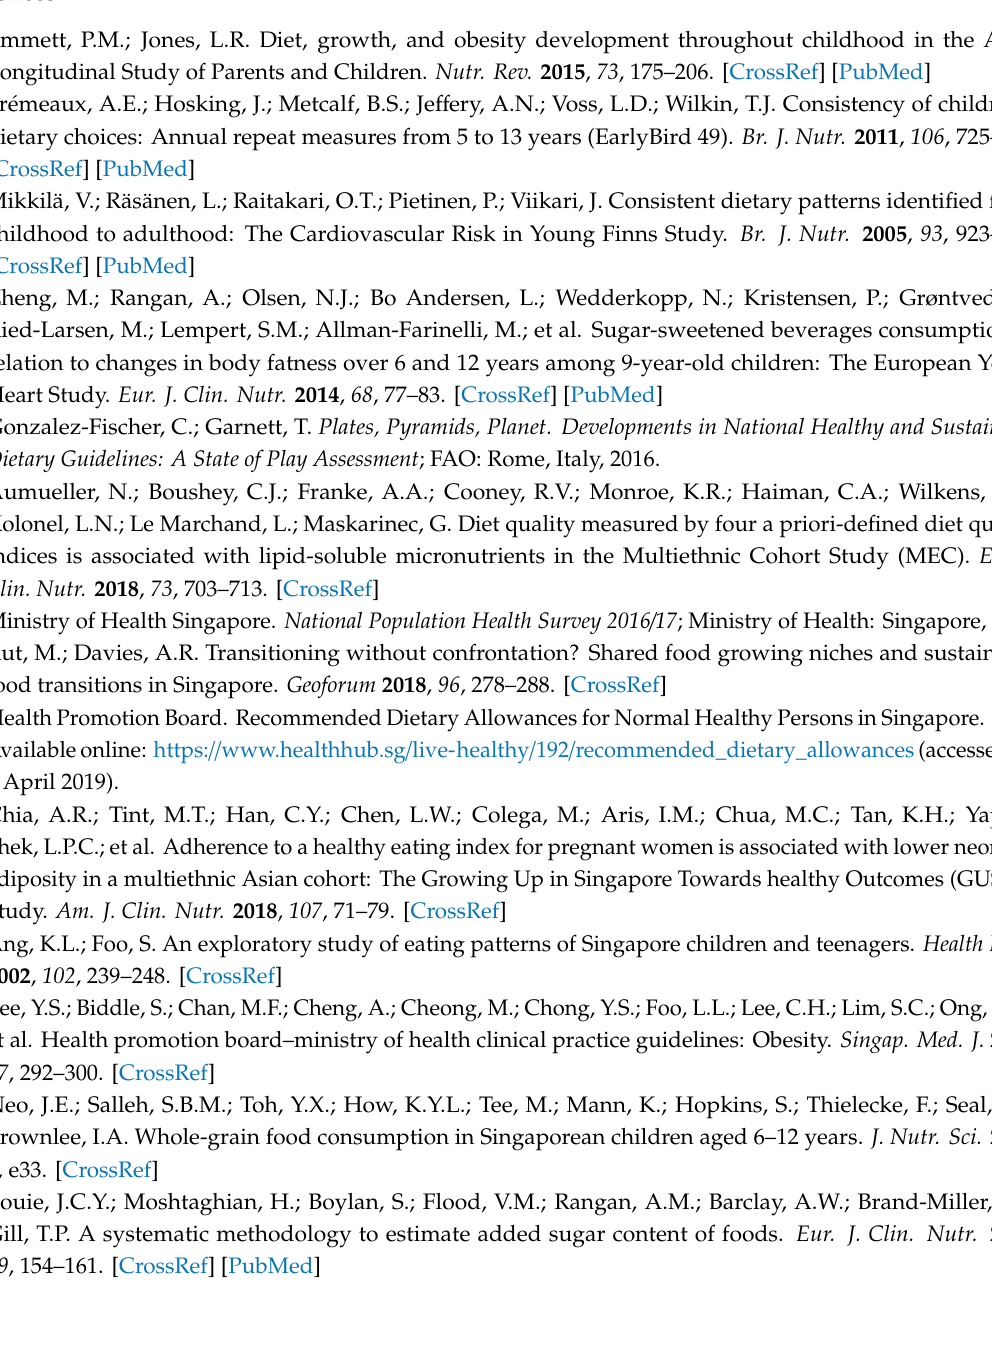
Table S1: Values used to derive component and total dietary quality scores in Singaporean